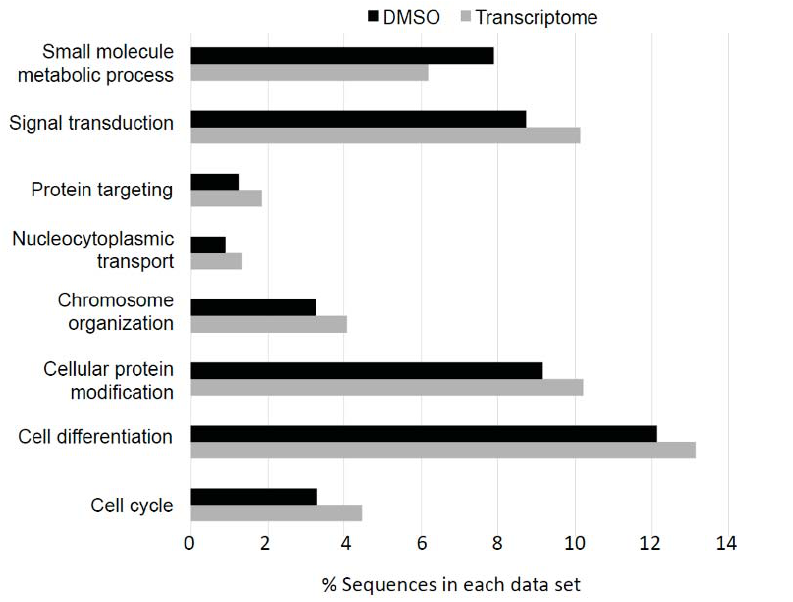
Figure 1. DMSO has an impact on many cellular processes. Gene Ontology Enrichment analysis showing the GO terms of transcripts deregulated after DMSO exposure compared to the control group (test set, black) and that exhibit statistically significant differences with the whole transcriptome (reference set, grey) (Fisher’s exact test, FDR < 0.1). The X -axis shows the percentage of sequences in each dataset. The Y -axis shows the GO terms. The expression of multiple genes with GO terms reflecting basic cellular processes is affected by DMSO exposure. The GO category “small molecule metabolic process” is enriched in genes deregulated by DMSO (black), while all the other categories are depleted compared to the whole transcript set (light grey).